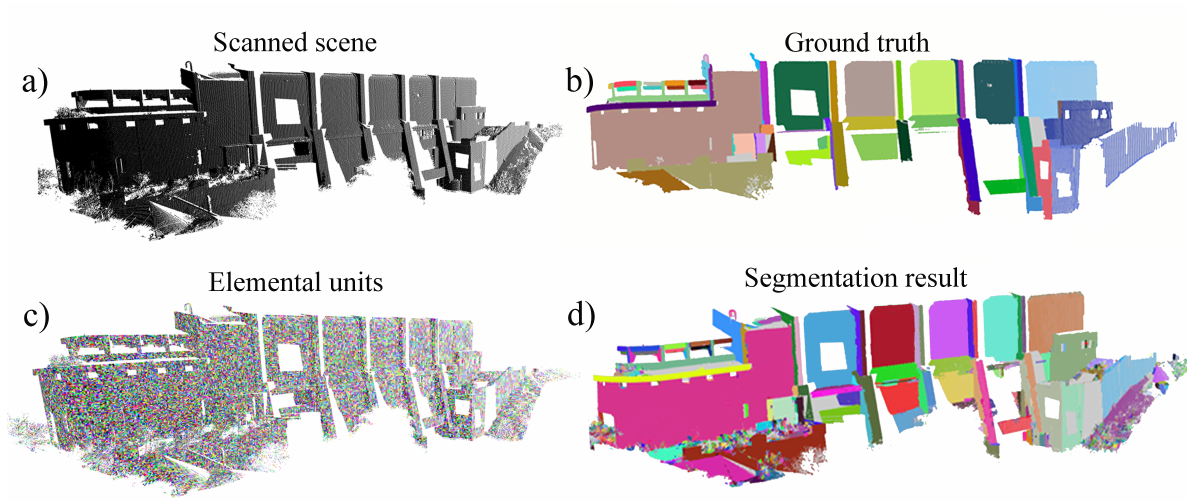
Figure 7: Segmentation results of second dataset. Object colors are chosen randomly